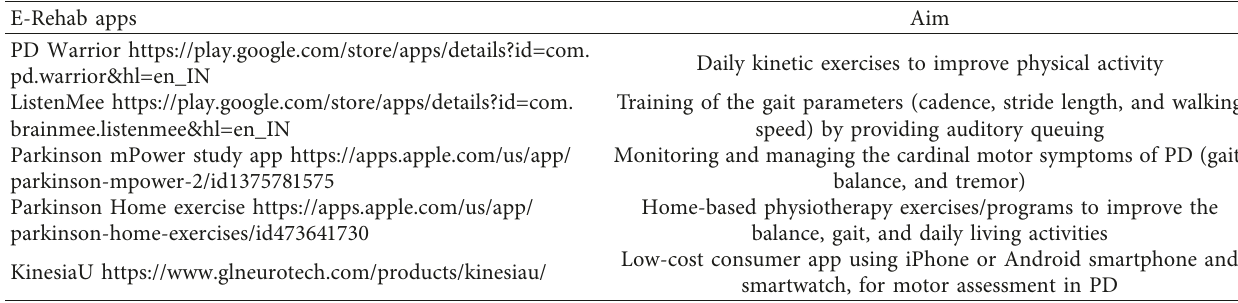
Table 3: Smartphone-based applications used in virtual reality-based rehabilitation of gait and balance in PD (modified from [47–49]). E-Rehab apps